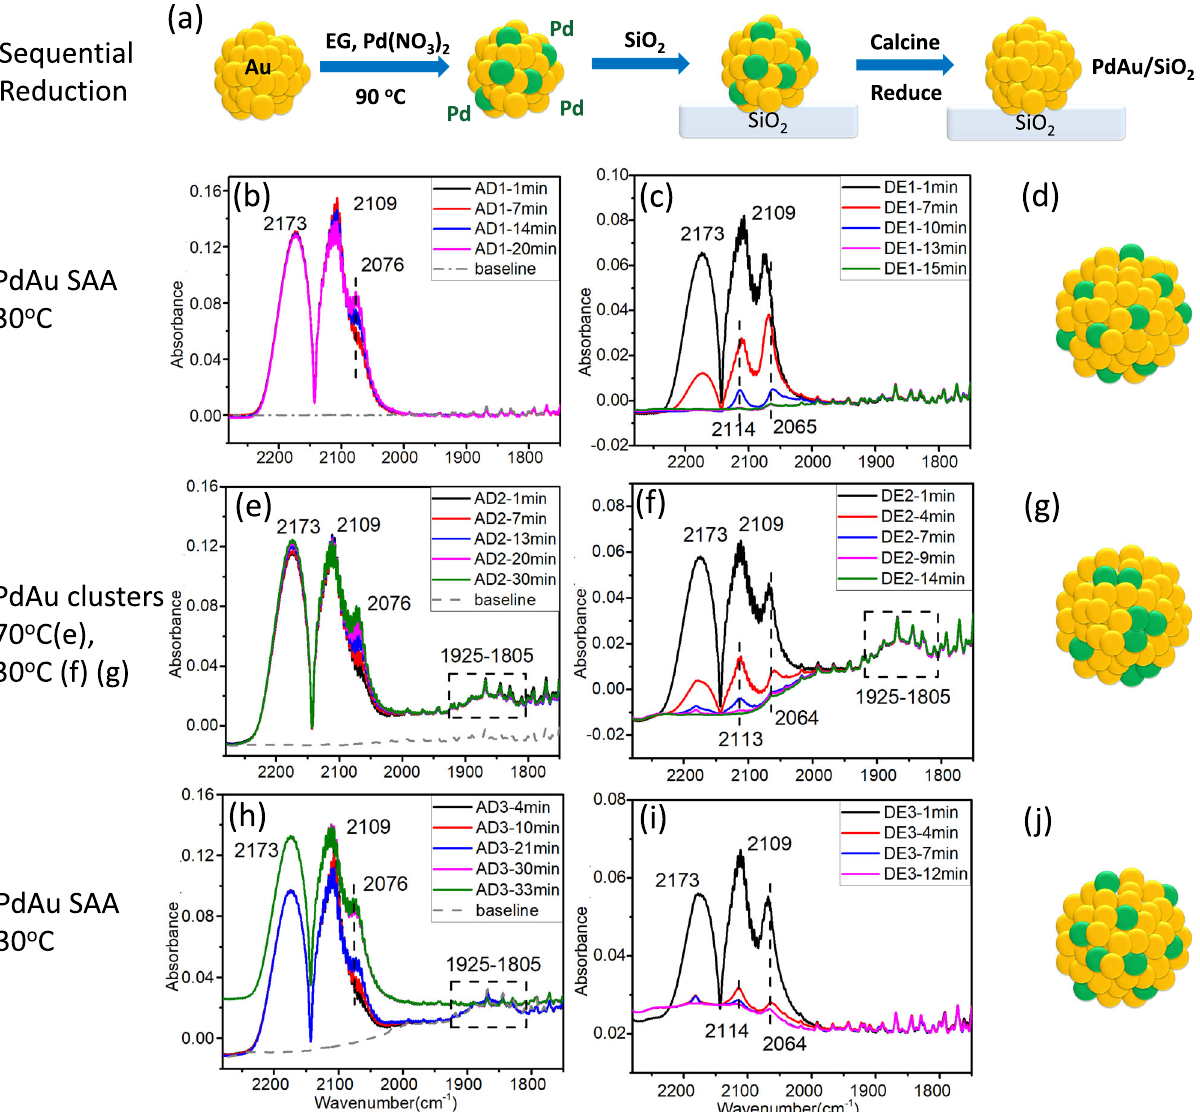
Fig. 2 In situ IR data of Pd clustering and redispersion induced by CO. a Schematic illustration of PdAu/SiO 2 synthesis in which the fi nal reduction step leads to migration of Pd to the interior of the NPs. CO-DRIFTS results and proposed structures of a Pd 0.02 Au 0.98 /SiO 2 sample at 30 °C ( b – d ), 70 °C ( e ), 30 °C ( f , g ), 30 °C ( h – j ) during 10%CO/He adsorption (AD) (P CO = 0.1 bar) and desorption (DE) process. Prior to the experiment, the sample was reduced at 200 °C in 5% H 2 /He for 1 h in situ. The labels in the upper right panels indicate the CO adsorption (AD), and desorption processes (DE) via He